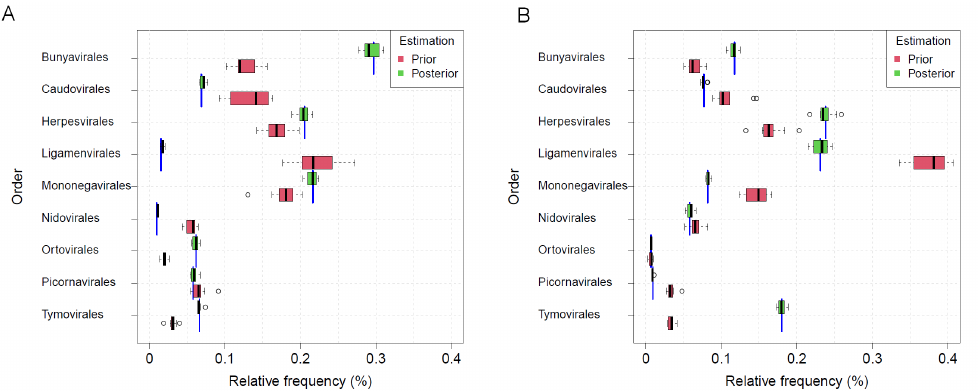
Figure 6. Comparison of estimated taxa frequencies, when there were unbalanced distribution of the reads in the nine viral orders. In the two example cases ( A , B ), the distributions of orders were drawn randomly from a Dirichlet-multinomial distribution. The blue lines mark the true frequency of each order.